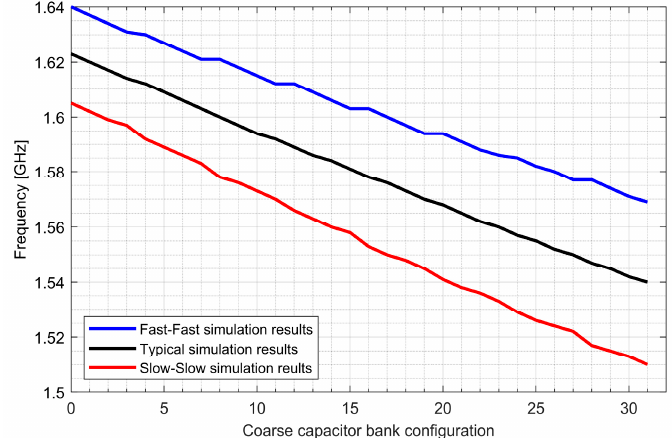
Figure 20. Tuning characteristics of the L1/E1 digitally controlled oscillator.